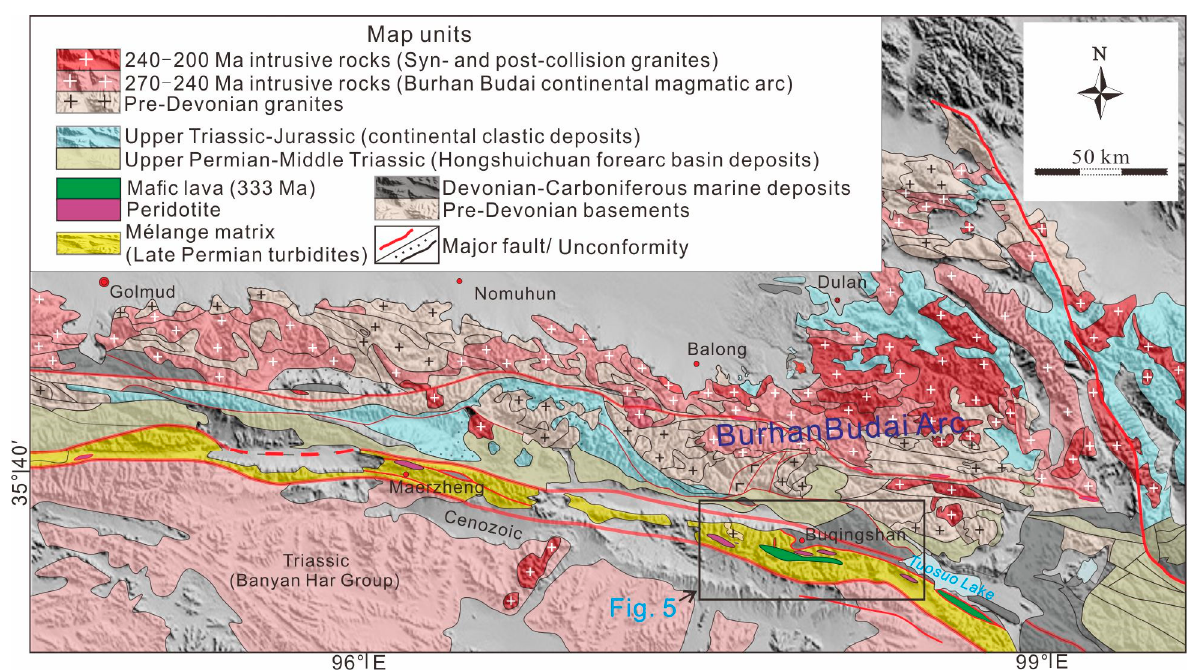
Figure 3. Geological map of eastern part of the East Kunlun Orogen.